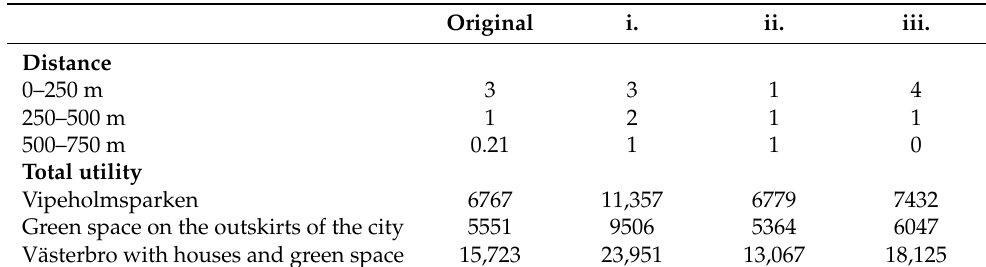
Table 5. Sensitivity analysis of the total utility with different assumptions about the value derived at different distances from the park. Original i. ii.